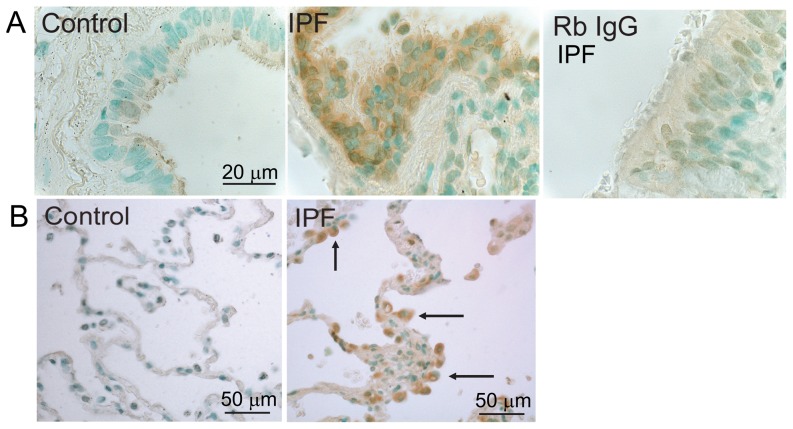
Immunostaining for MMP-8 is increased in IPF lungs.Lung tissue was obtained from IPF patients undergoing lung transplantation and unused transplant donor lungs (control). Immunoperoxidase staining for MMP-8 was performed on formalin-fixed IPF and control lung sections. In A, there is positive (brown) staining for MMP-8 in bronchial epithelial cells in an area of severe fibrosis in the IPF lung but not in bronchial epithelial cells in the control lung section. B shows positive (brown) staining for MMP-8 in cells in fibrotic parenchyma in IPF lungs (indicated by the arrows) but not in control lung parenchyma. Lung sections stained with a non-immune rabbit IgG control primary antibody (Rb IgG) showed minimal staining. These results are representative of 3 different lung sections per group. Magnification is X 400.